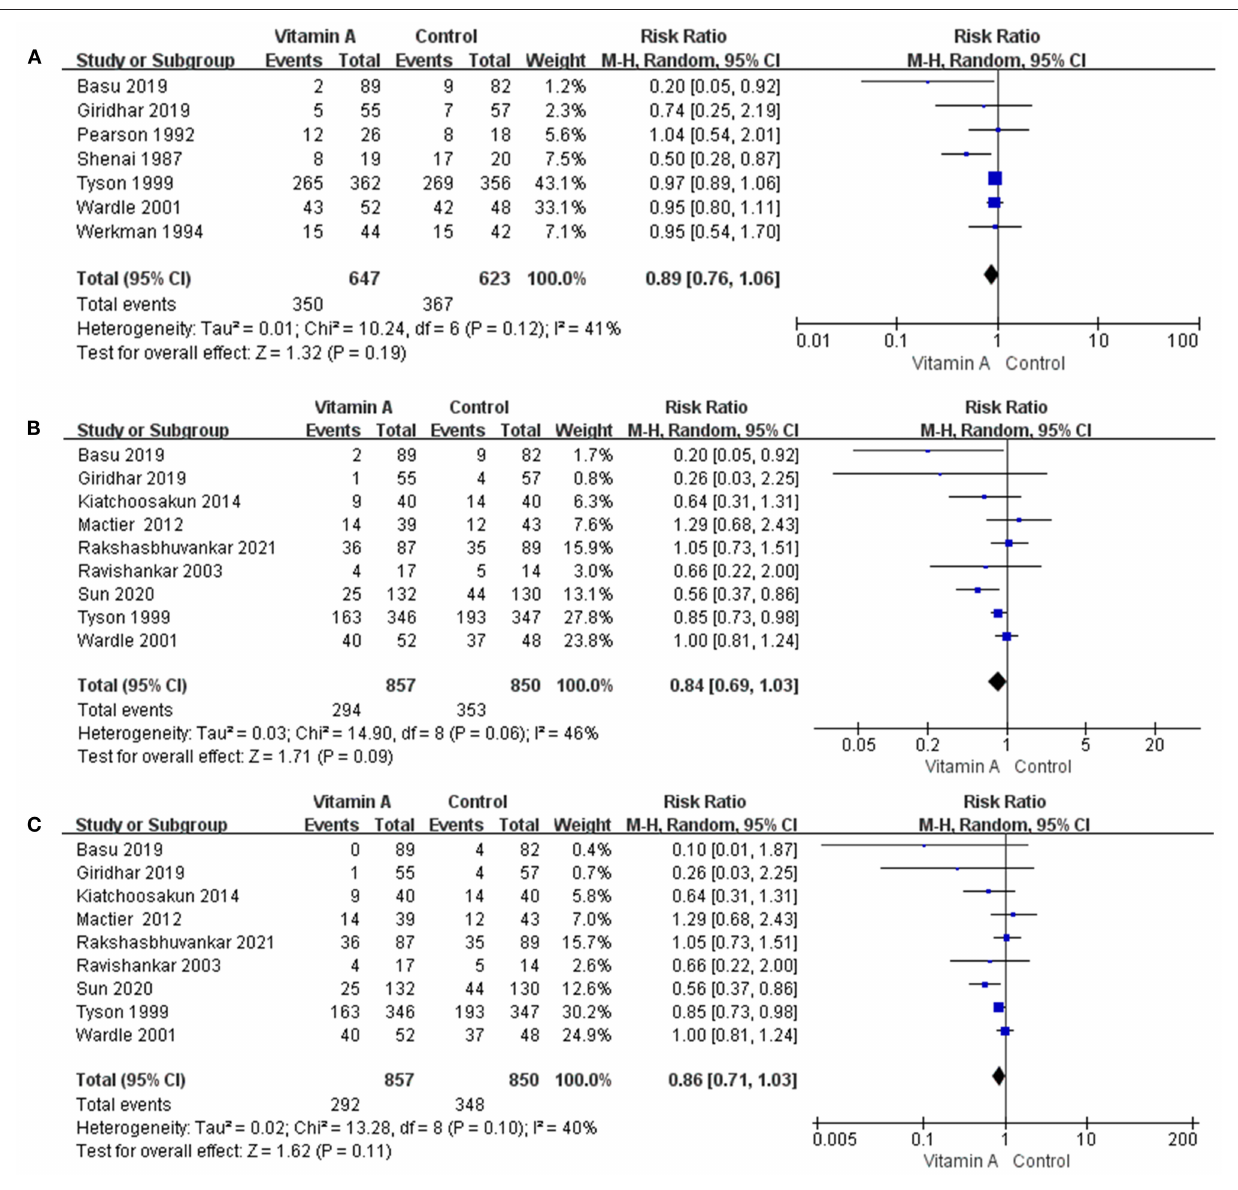
FIGURE 3 | The forest plot for the incidences of oxygen dependency among survivors. (A) The forest plot for the incidence of oxygen dependency for 28 days among survivors. (B) The forest plot for the incidence of oxygen dependency at 36 weeks’ PMA among survivors. (C) The forest plot for the incidence of moderate to severe BPD among